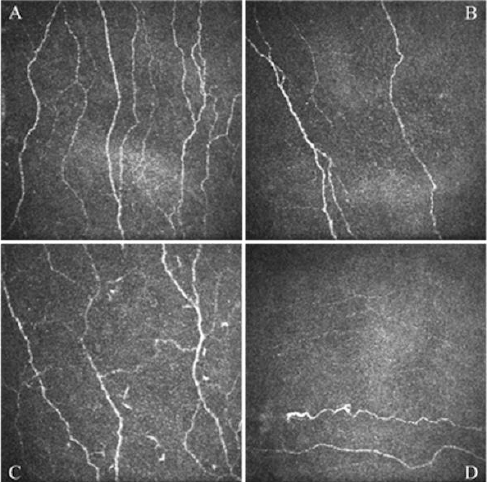
Figure 1. In vivo confocal microscopy scans of the corneal sub-basal nerve plexus obtained in a healthy patient ( A ) and in different patients affected by dry eye disease ( B – D ). All images are in the scale of 400 × 400 μm. Part ( A ) shows a normal nerve plexus, part ( B ) shows a nerve plexus with reduced density, part ( C ) shows a nerve plexus with increased tortuosity, part ( D ) shows an altered nerve plexus characterized by the presence of neuroma.